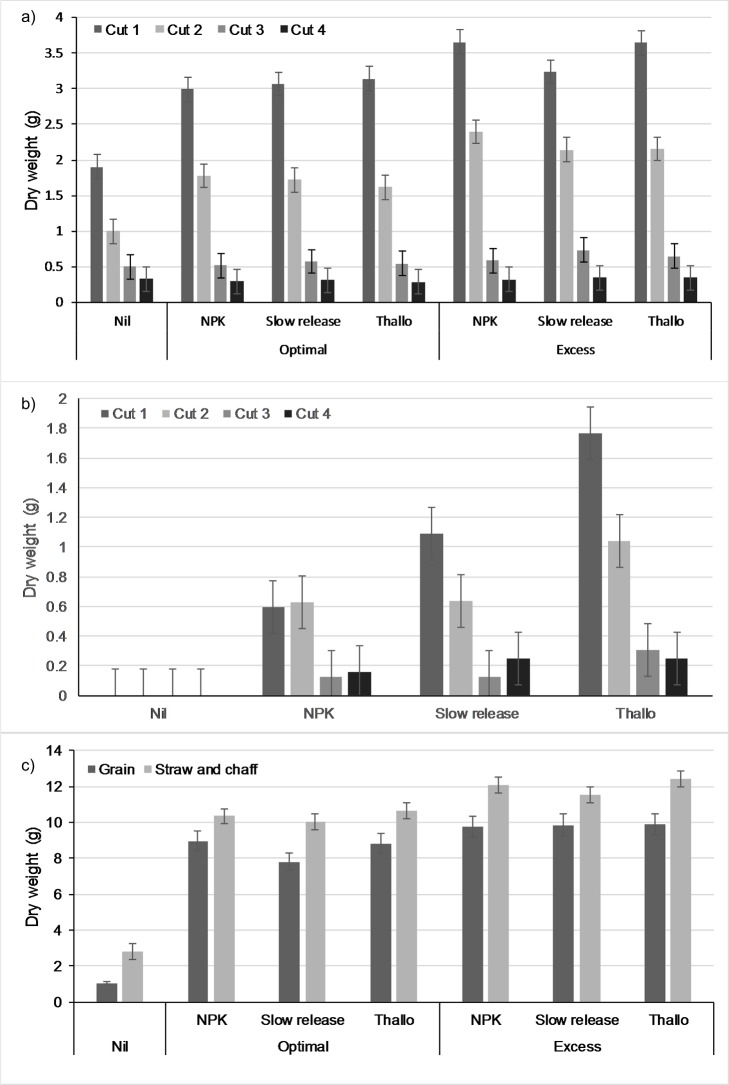
Total biomass production (g dry matter per pot) in the three pot experiments according to the fertilizer treatment and fertilizer application level.a) grass grown in soil across 4 successive cuts, b) grass grown in sand across 4 successive cuts, and c) wheat grain and straw+chaff production. Values are the mean of 3 replicates, and their standard error.